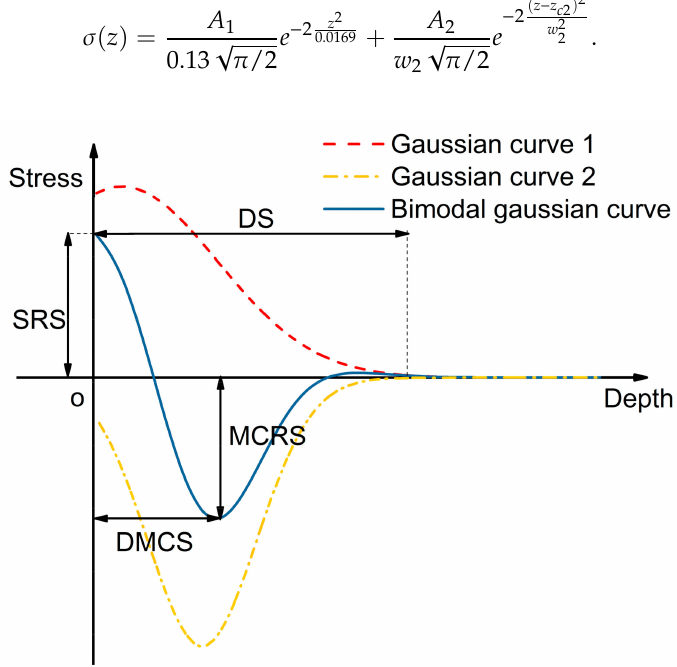
Figure 3. The bimodal Gaussian